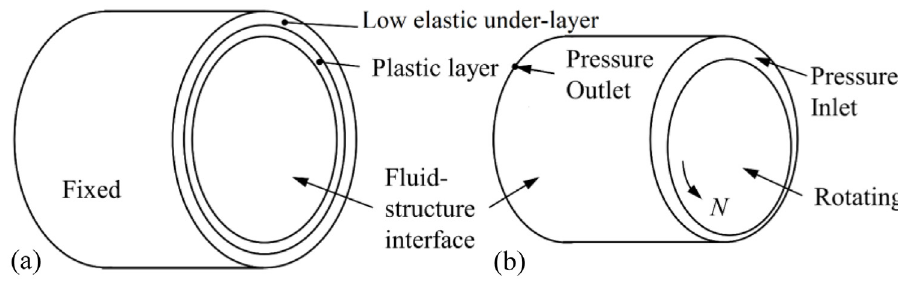
Fig. 3. Model and boundary conditions of (a) Bush and (b) Water fi lm.